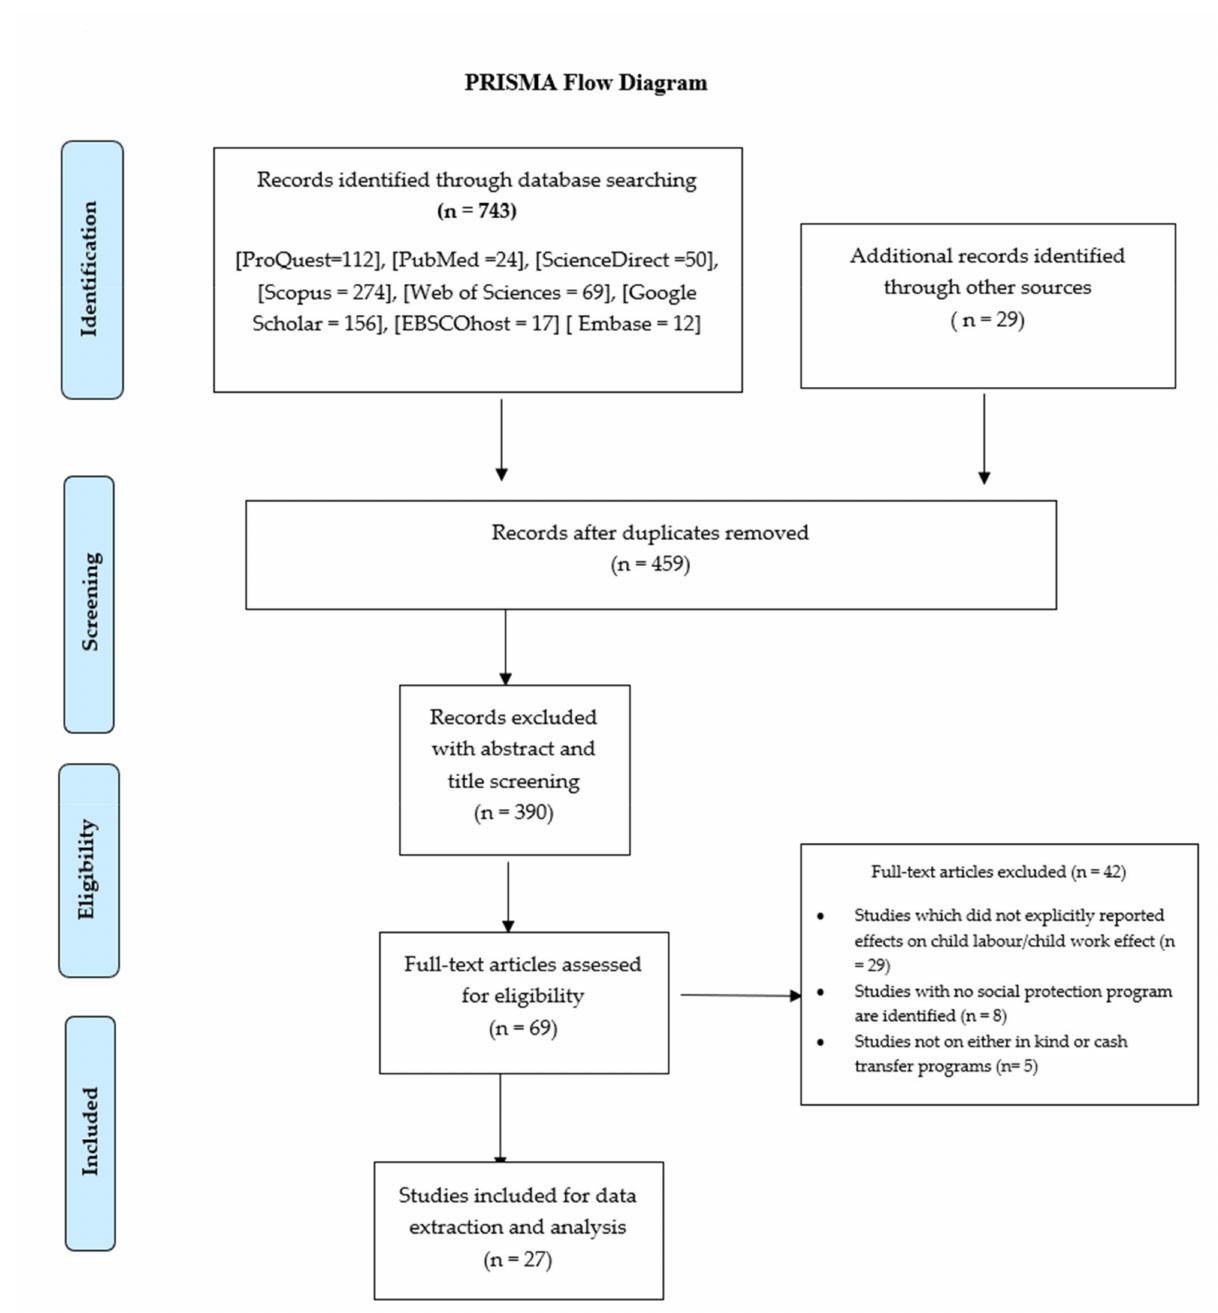
Figure 1. Prisma Flow